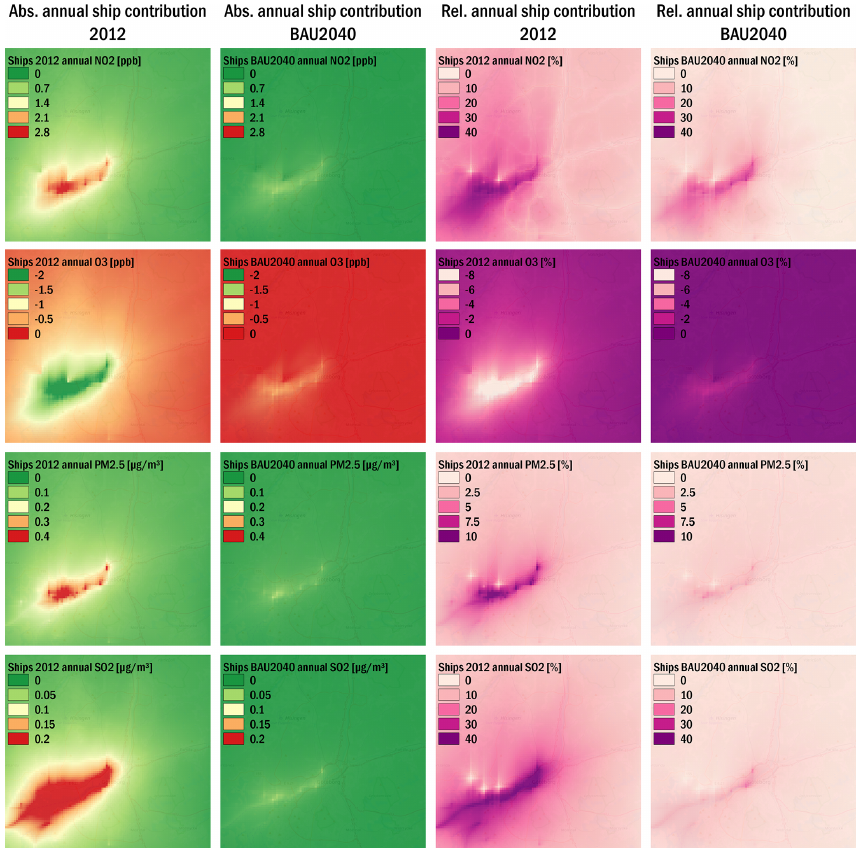
Figure 6. Absolute contributions of local ship emissions to annual mean concentration levels in Gothenburg in 2012 (column 1) and BAU2040 (column 2), as well as the relative contributions (columns 3 and 4). ©OpenStreetMap contributors 2019. Distributed under a Creative Com- mons BY-SA License.